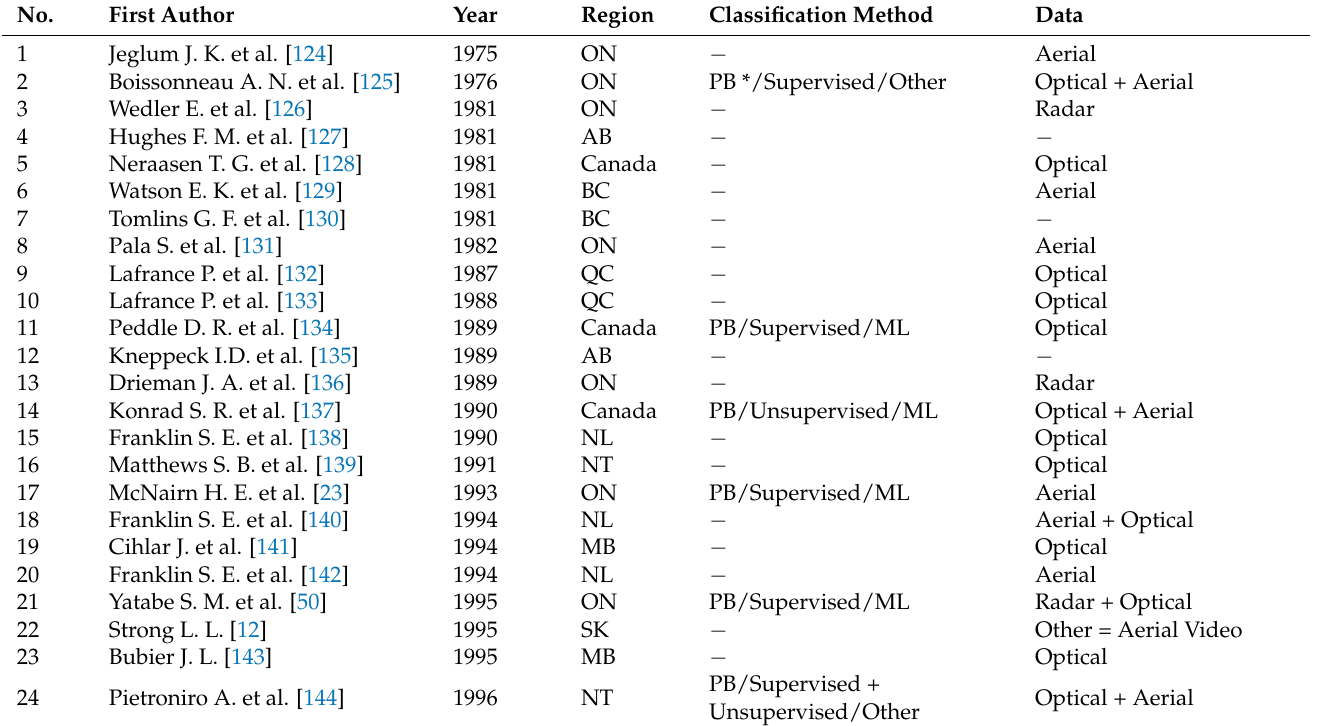
Table A2. List of 300 studies and main